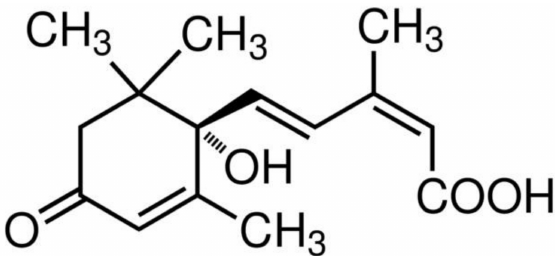
Figure 2. The structure of abscisic